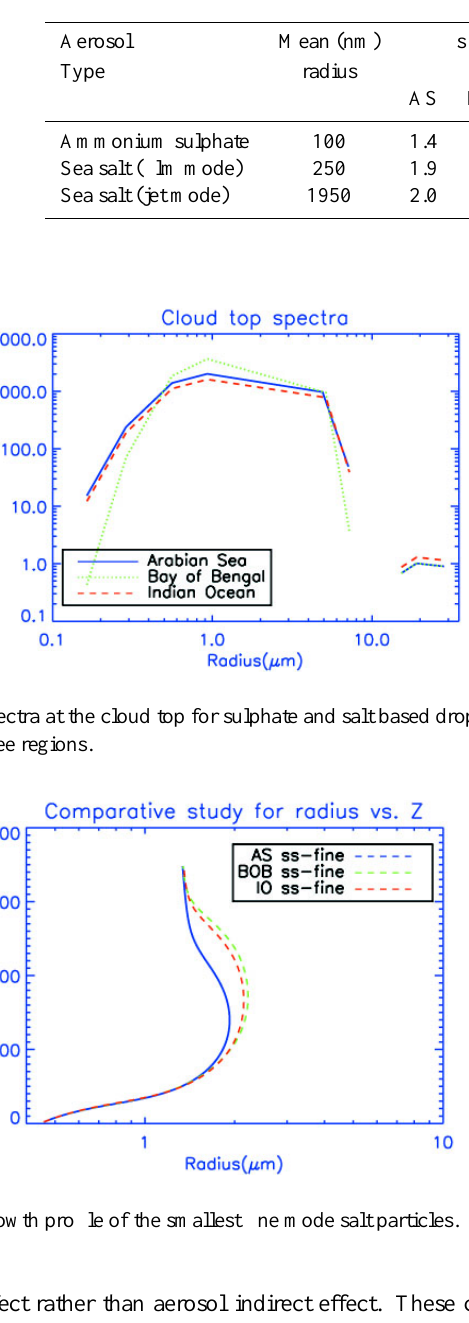
Table 1. Input aerosol spectral properties for the three regions.